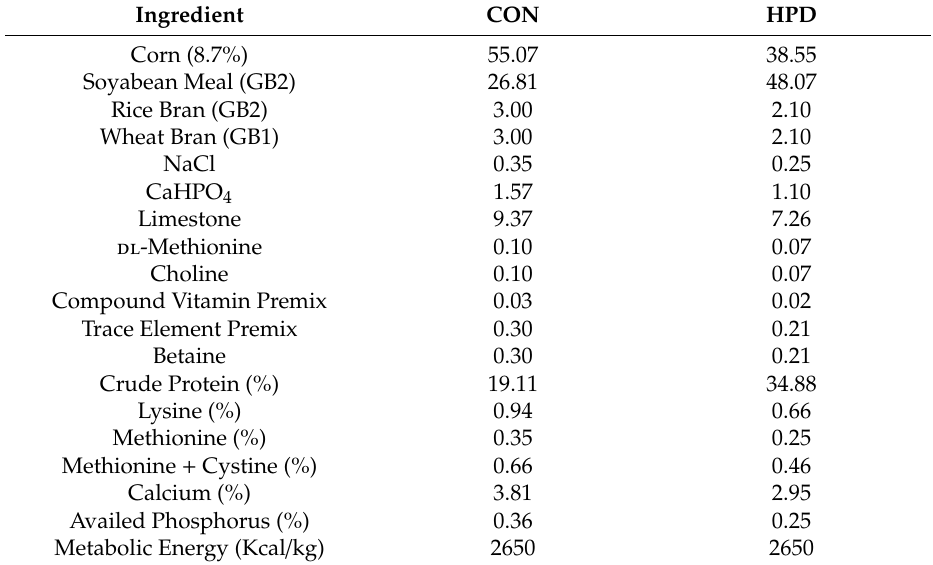
Table 1. Feed ingredients of first